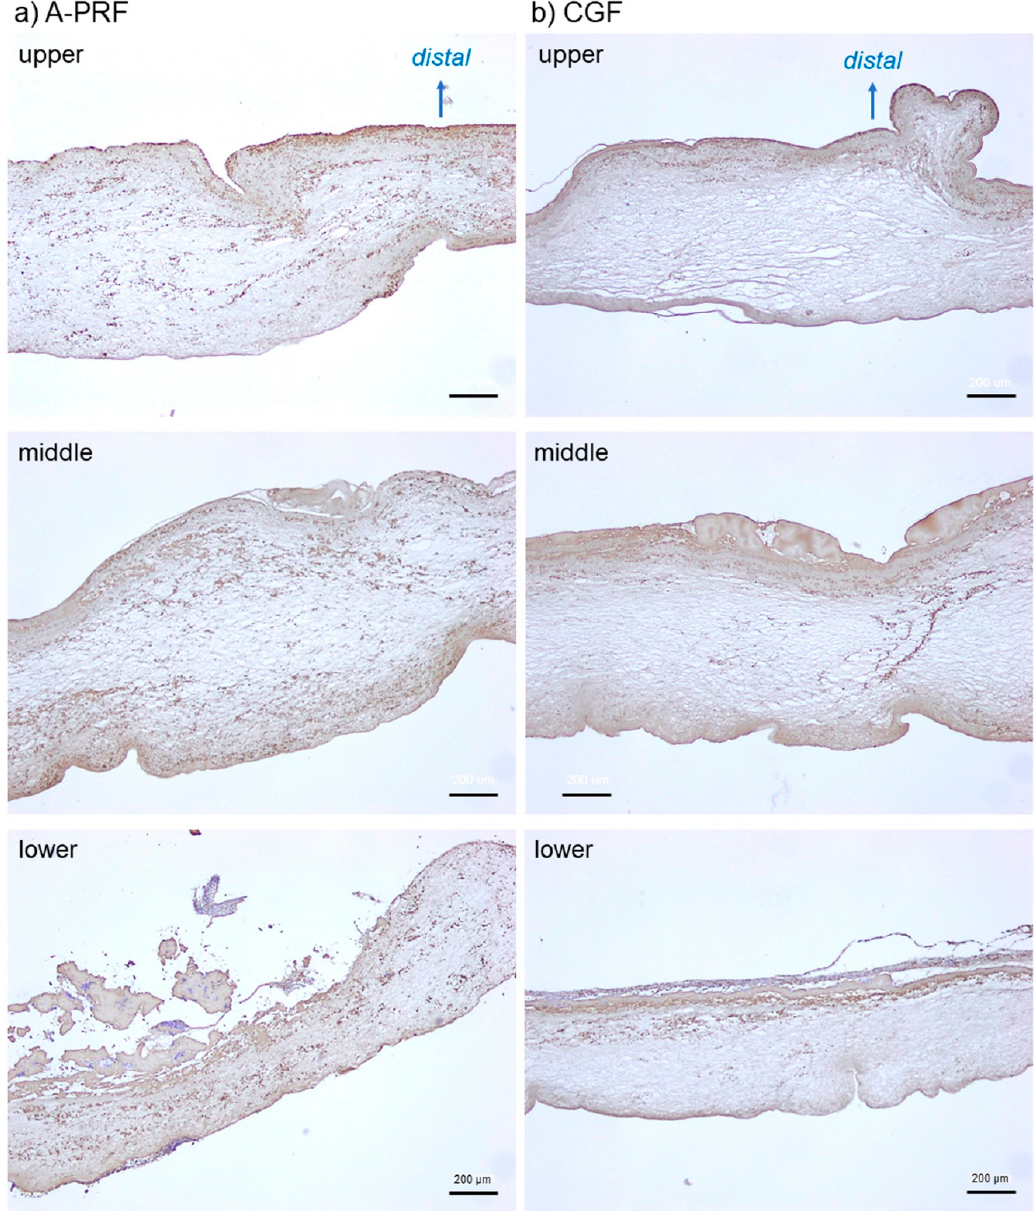
Figure 4. Representative photomicrographs of conventional immunohistochemically-stained sections showing platelet distribution in A-PRF prepared by slow spin ( a ) and CGF prepared by fast spin. ( b ) Brown particles represent platelets. Scale bar, 200 μ m.